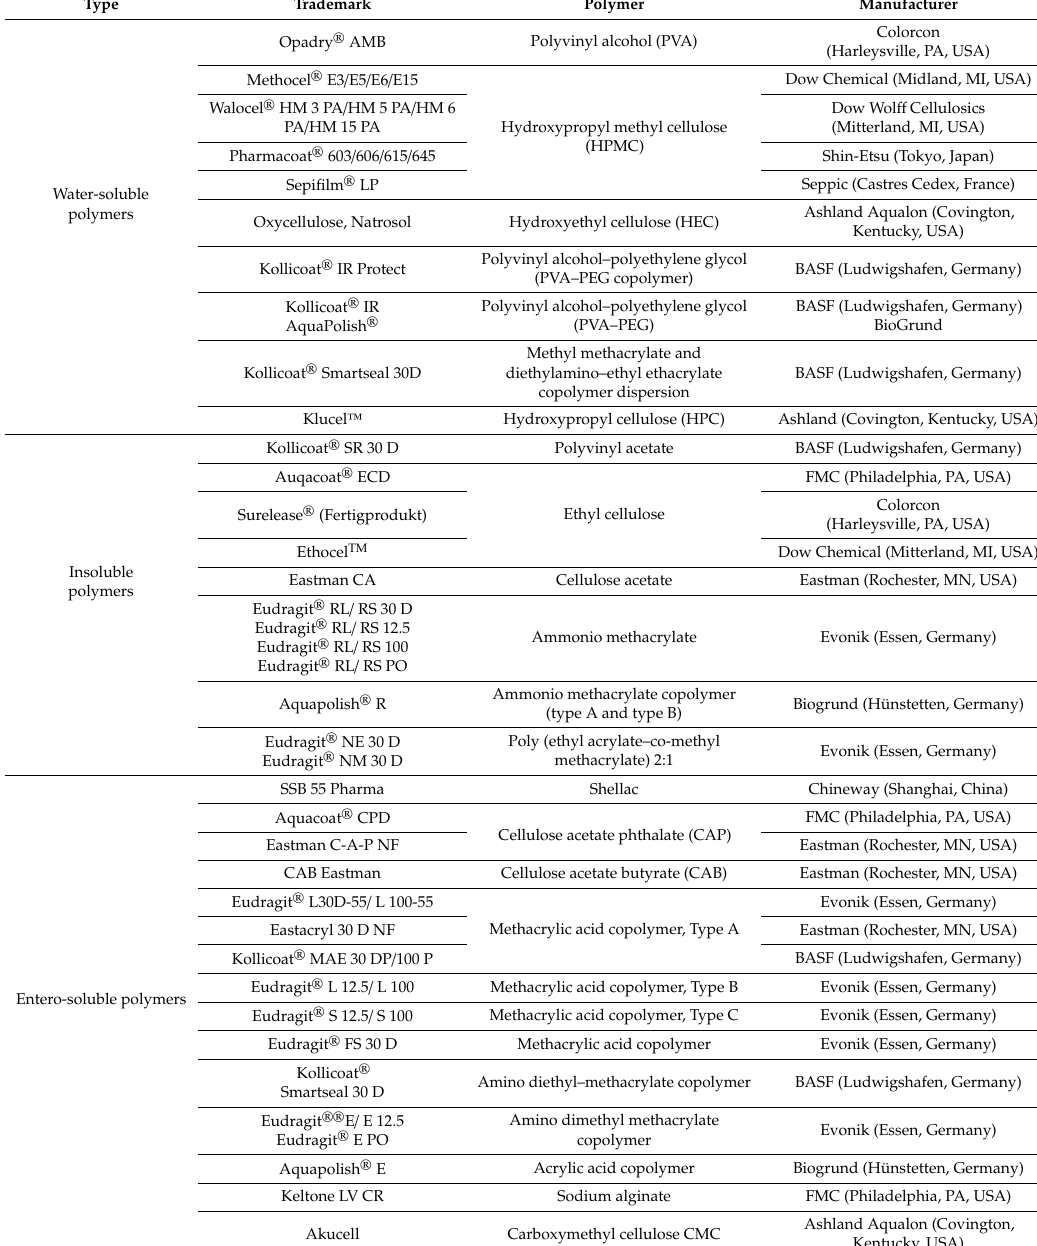
Table 1. Polymers used for moisture barrier film